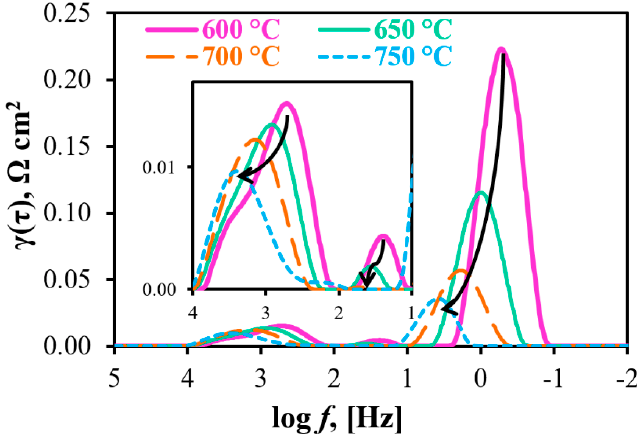
Figure 7. DRT results for the obtained impedance spectra (see details in Figure 5a).